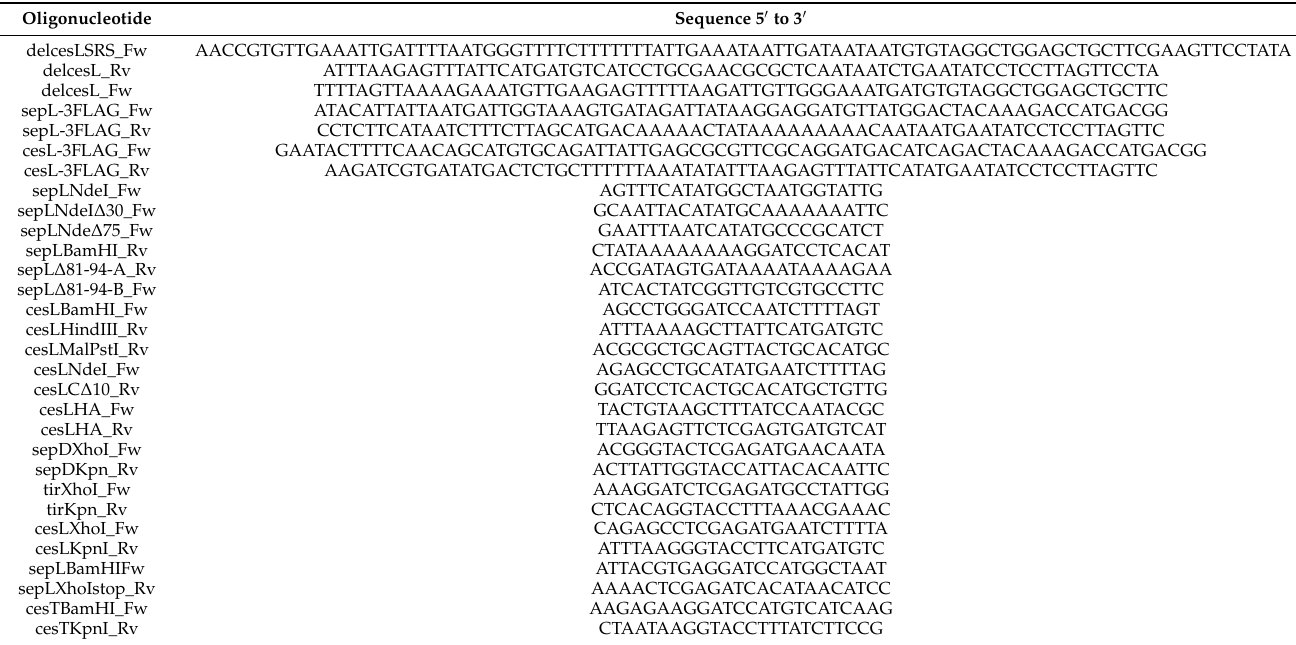
Table 2. Oligonucleotides used in this